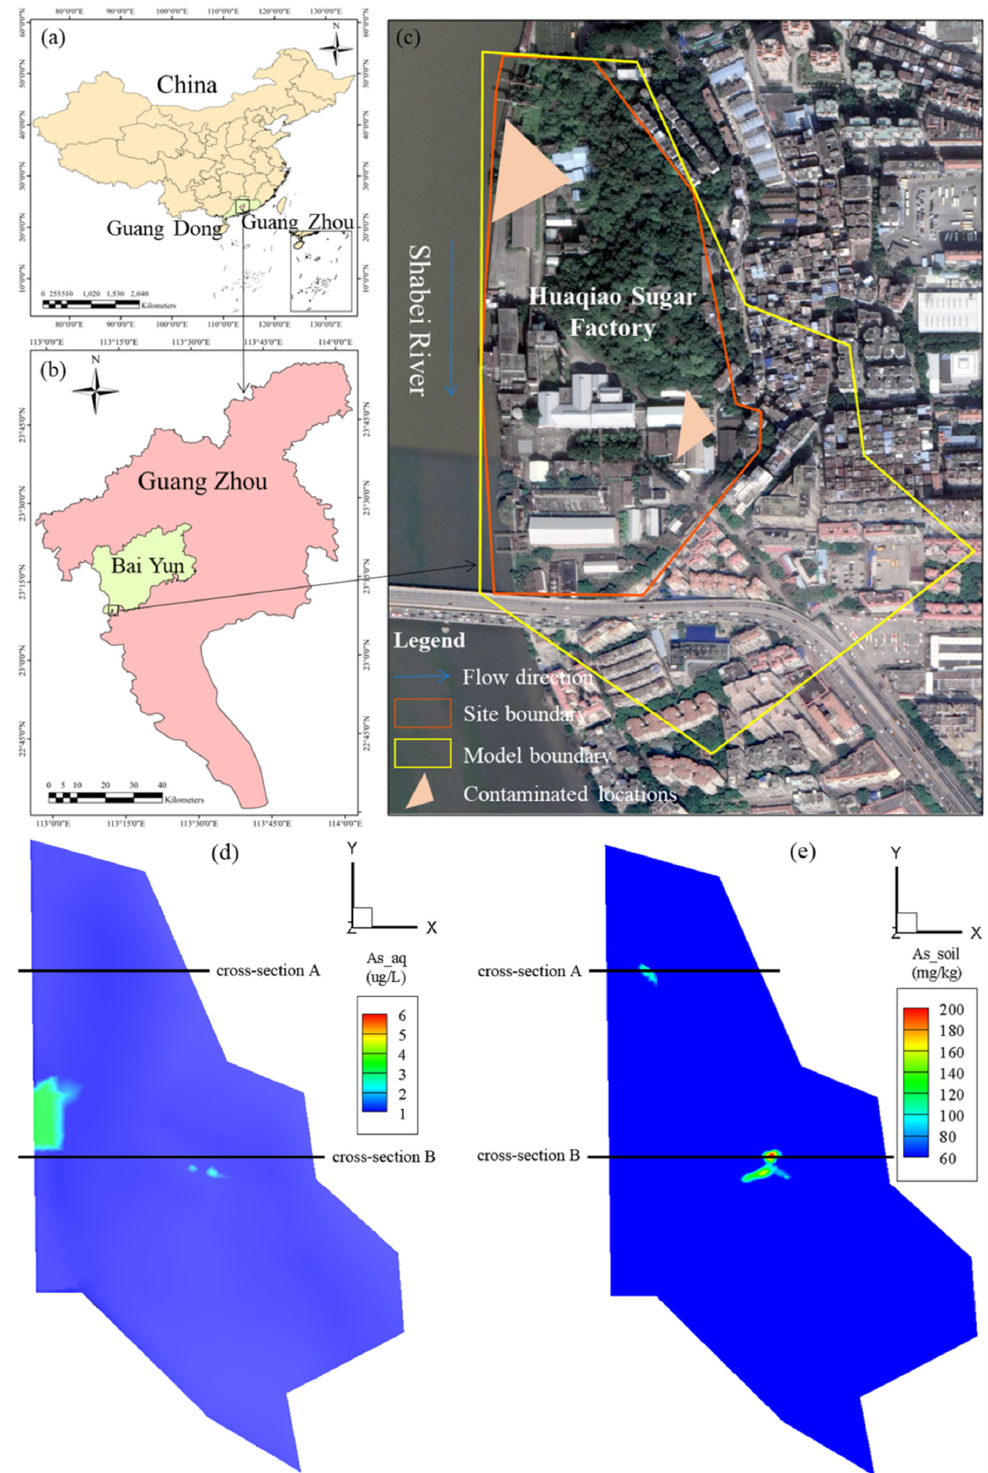
Figure 2. The location of the study site including site and modeling boundaries, and contaminated locations ( a – c ). The initial distributions of arsenic concentrations in groundwater ( d ) and soil ( e ). Here, As_aq and As_soil represented groundwater arsenic concentration, soil arsenic con- centration, respectively. The cross-sections A and B were the cross-section of the contaminated locations,